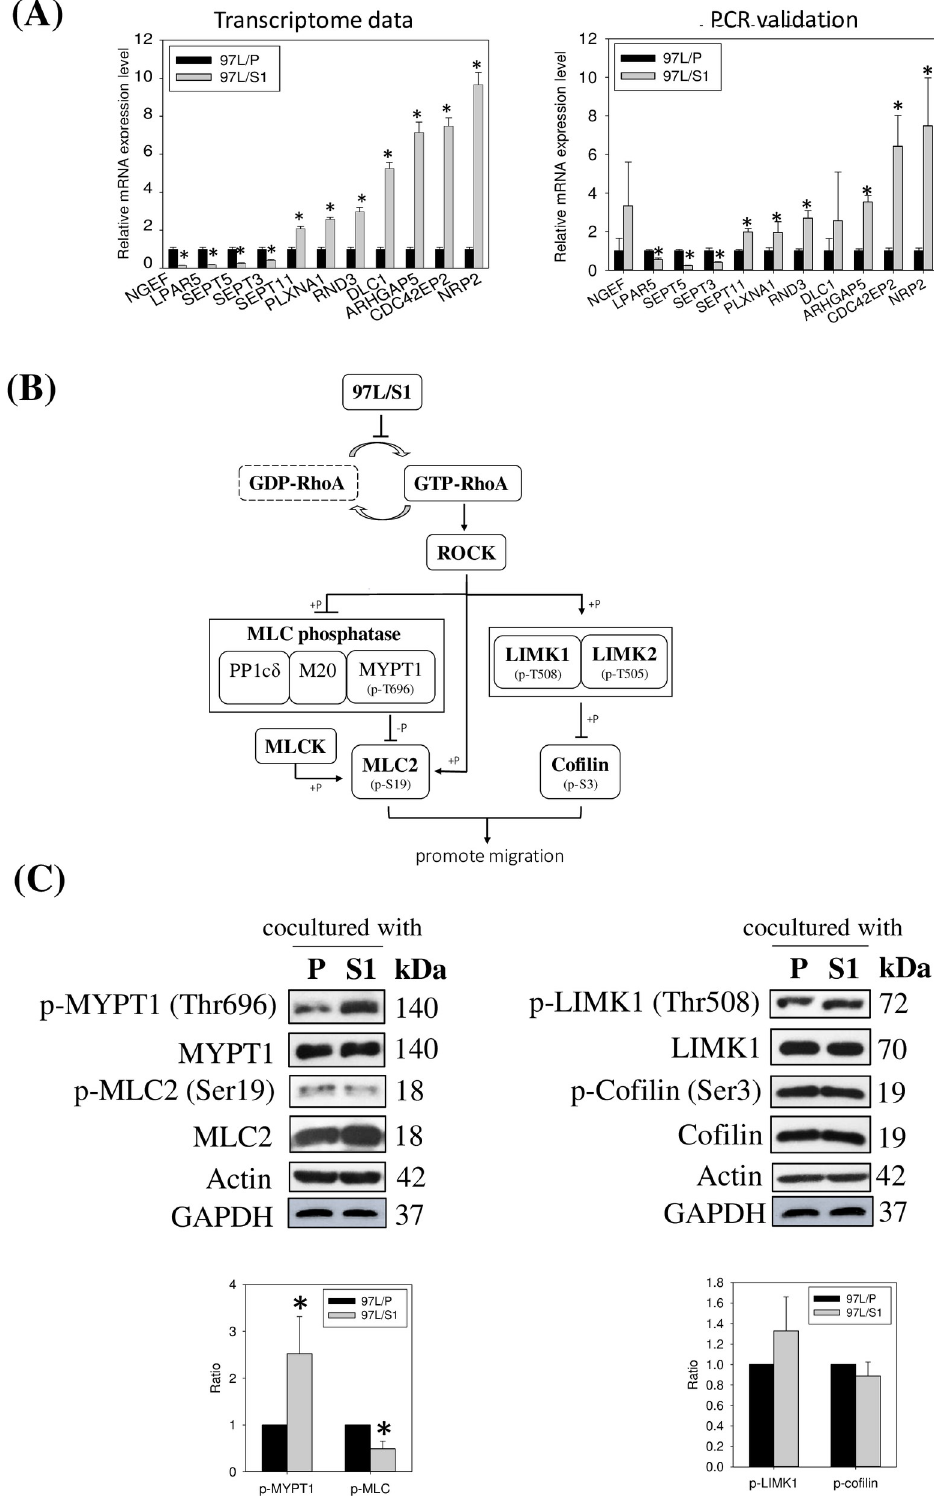
Fig 5. The validation of the IPA-predicted RhoA pathway suppression in THP-1 cells co-cultured with MHCC97L/S1. (A) A comparison of 11 RhoA pathway-associated DEGs between transcriptome data and qPCR validation. (B) A schematic diagram shows the predicted inhibitory effect of MHCC97L/S1 on the co-cultured